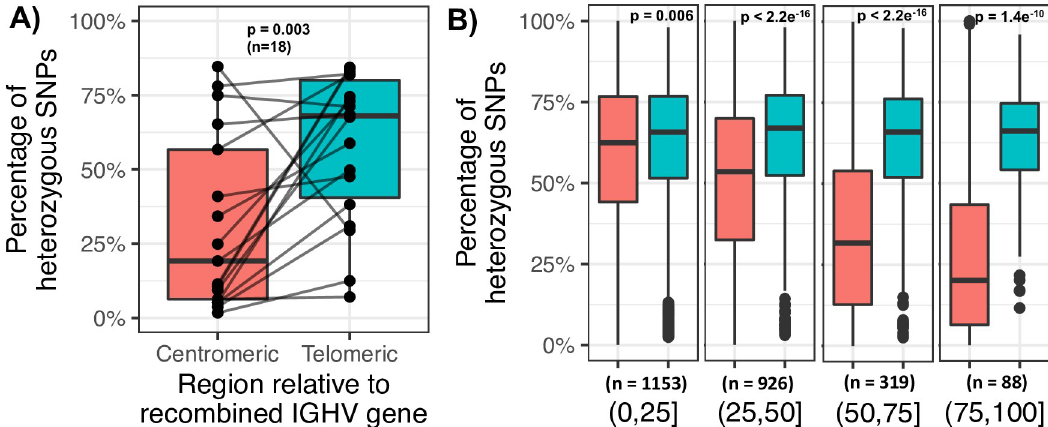
Fig 4. Differences in heterozygosity in regions centromeric and telomeric of IGHV gene segments selected during V(D)J recombination, and the relationship with clonality bias. (A) A boxplot showing within sample differences in the percentage of heterozygous SNPs in the regions centromeric and telomeric of the IGHV gene selected for V(D)J recombination across monoclonal samples (n = 18). (B) Similar to (A), boxplots showing within sample differences in the percentage of heterozygous SNPs in the regions centromeric and telomeric of the IGHV gene selected for V(D)J recombination across all samples, partitioned by the degree of